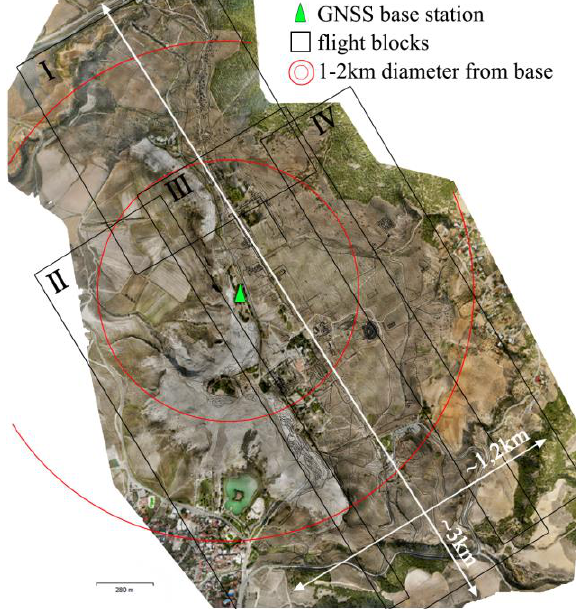
Figure 4. The resulting orthoimage of the site with indication of: the 4 flight blocks; the main extension dimensions and the GNNS base station position used for RTK/PPK positioning and its range of up to 1